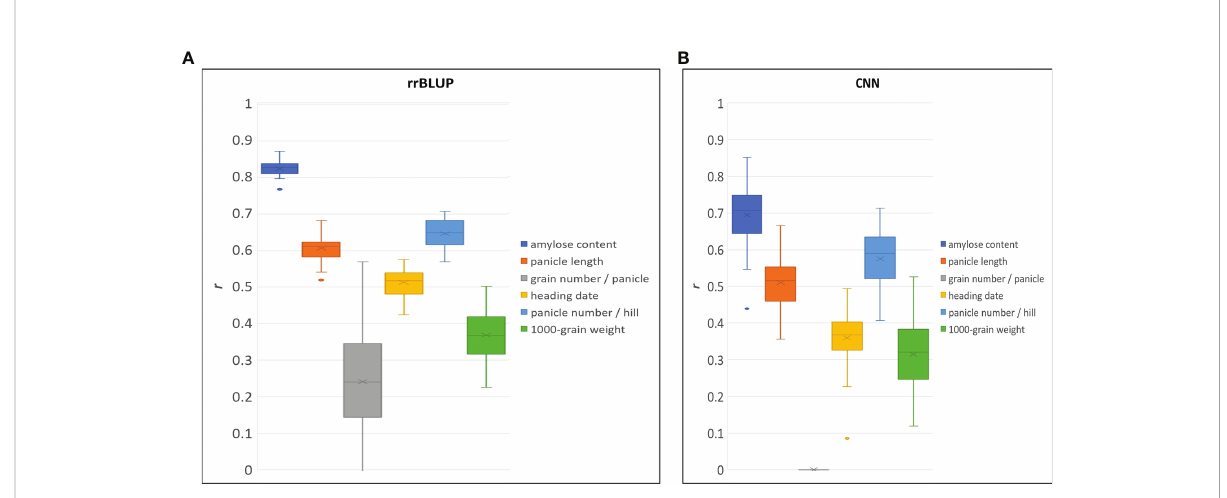
FIGURE 8 Genomic selection predictive ability (r) for different traits by using rrBLUP (A) , and CNN (B)